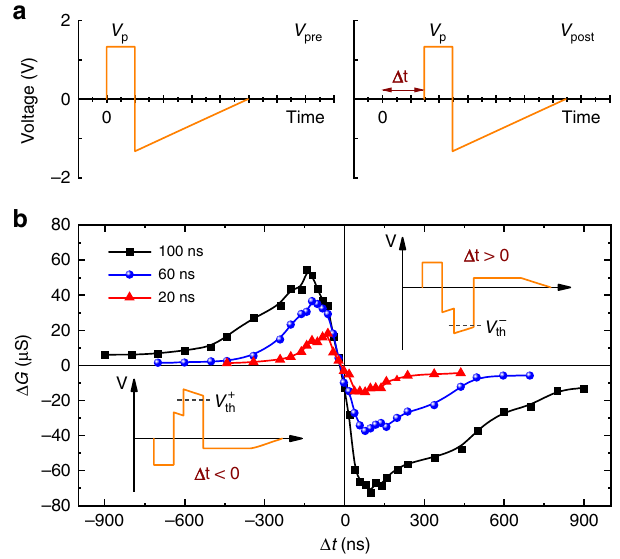
Fig. 4 Ultrafast arti fi cial synapses based on FTJs. a Applied programmable voltage waveforms for pre-synaptic and post-synaptic spikes, respectively. b STDP measurements in the FTJ. Modulation of the FTJ conductance ( Δ G ) as a function of the delay ( Δ t ) between pre-synaptic and post-synaptic spikes. Insets show the waveforms produced by the superposition of the pre-synaptic and post-synaptic